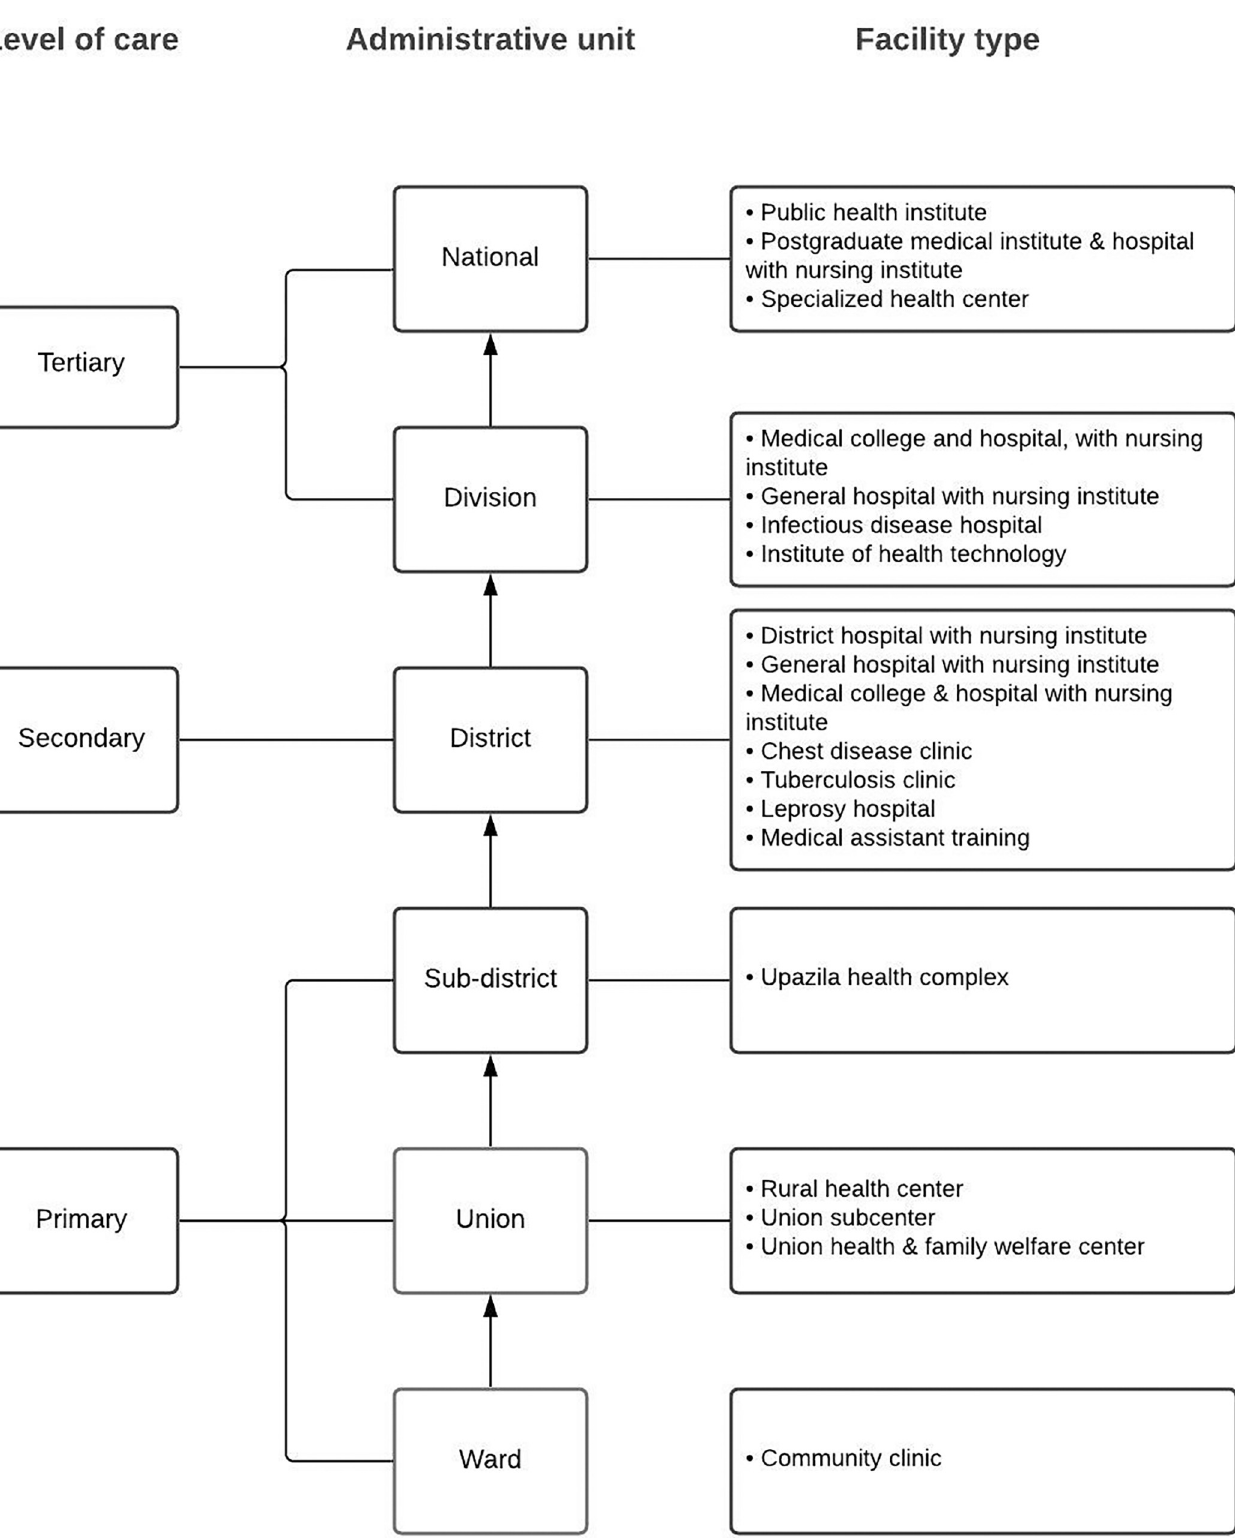
PLOS Global PublicHealth | https://doi.org/10.1371/journal.pgph.0000164 July 25,